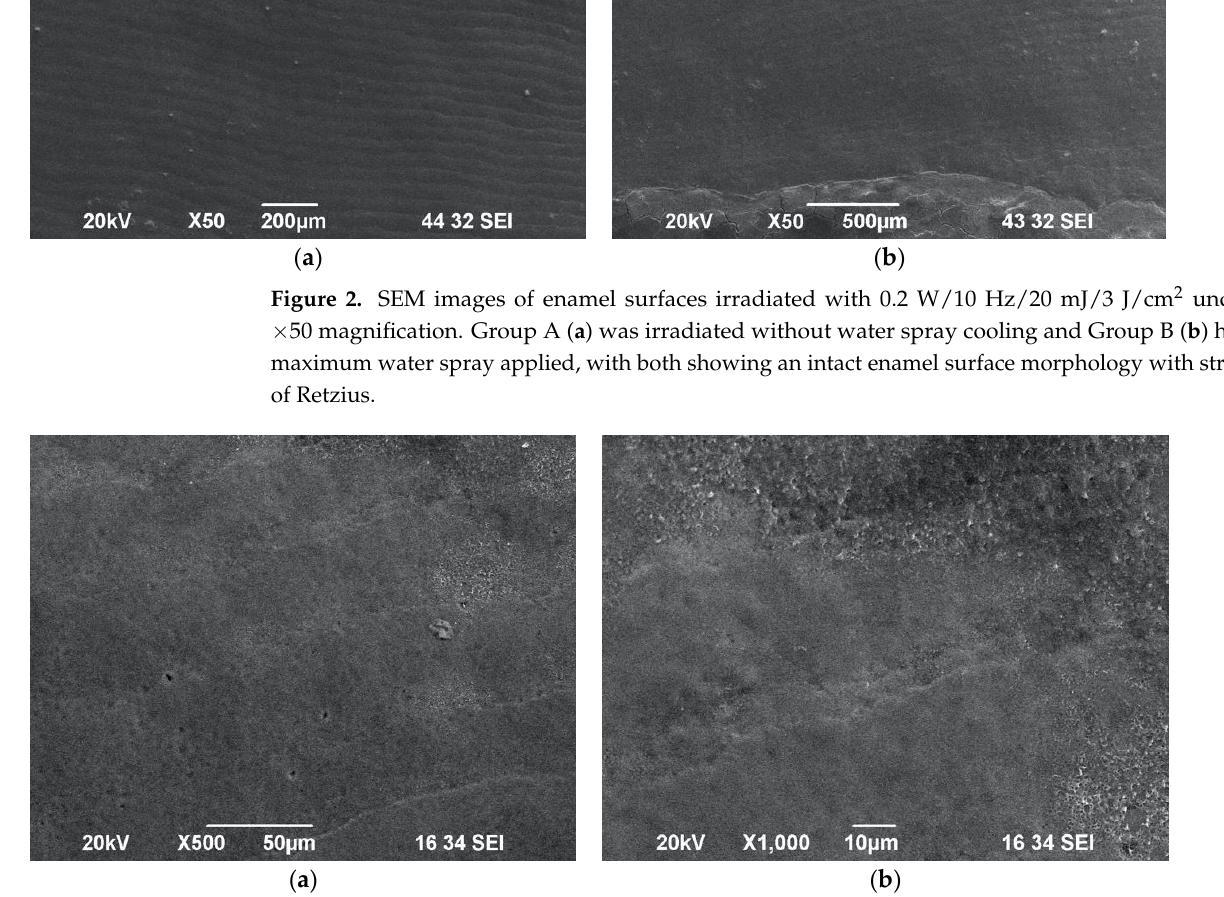
( b ) Figure 4. SEM images of enamel surface morphology following irradiation with 0.6 W/15 Hz/40 mJ/ 10 J/cm 2 without water spray cooling—Group D—under ×50 magnification ( a ) and ×1000 magnifi- cation ( b ), showing presence of impact craters and scaly surface. Laser-induced impact craters and scaly ablated morphology on the enamel surface were observed as well in Group E (Figure 5a,b) and Group F (Figure 6a,b) samples irradi- ated with the following laser settings: 0.75 W/15 Hz/12 J/cm 2 with or without maximum water cooling, at a distance of 10 mm from target area. Hence, it can be considered as an ablative protocol. The presence of wide scaly surfaces with impact craters and exposed prisms was ob- served in the samples of Group G (Figure 7a,b) and Group H (Figure 8a,b). Additionally, the impact craters appeared to be of a wider diameter and at a greater depth compared to the Group G samples irradiated with water when the samples in Group H were irradiated with the following laser protocol without water spray: 1 W/20 Hz/17 J/cm 2 ,.